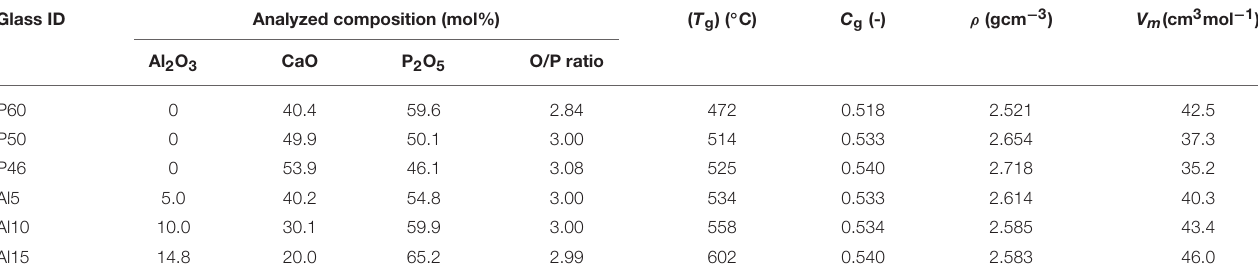
TABLE 1 | Analyzed chemical compositions, glass transition temperature ( T g ), density ( ρ ), atomic packing density ( C g ), and molar volume ( V m ) of the as-prepared glasses. Glass